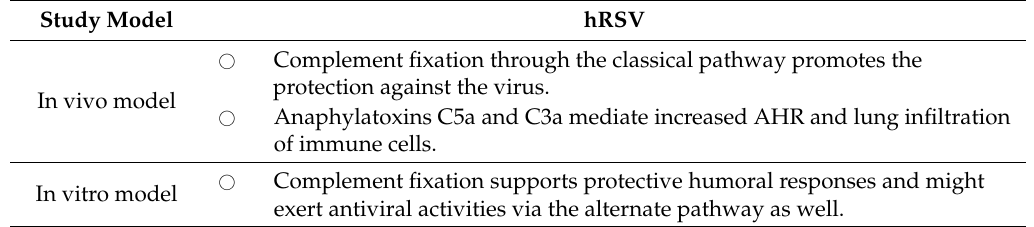
Table 7. Role of the complement system in the pathology caused by